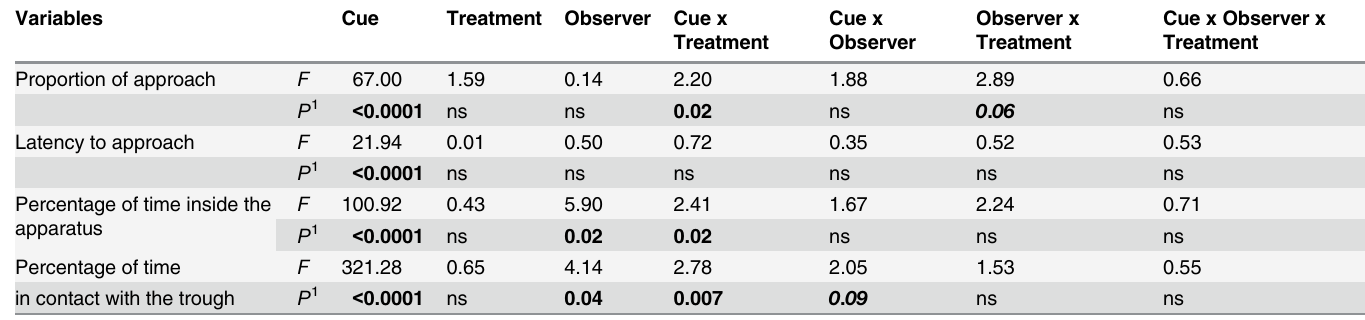
Table 1. Main effects on approach behaviour following playback of trained (positive (P) and negative (N)) and ambiguous (AP, AM and AN) cues during cognitive bias tests, in presence or absence of a human observer, for piglets having previously experienced gentle (GEN), rough (ROU) and minimal contact